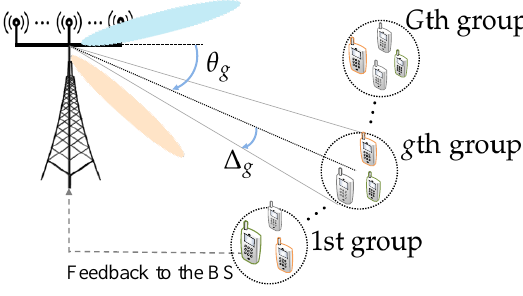
Figure 1. Illustration of our system